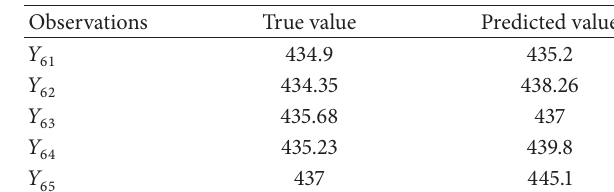
Table 1: Prediction of the opening stock prices up till 5 steps ahead of the recorded